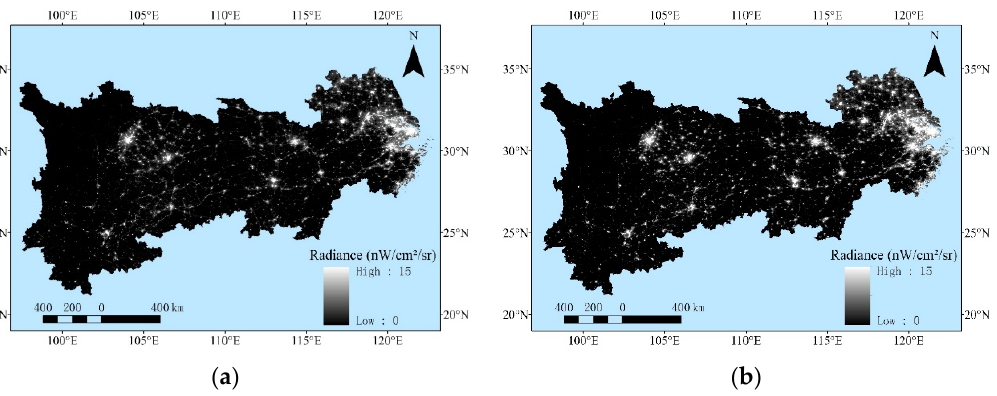
Figure 2. The night-time light images for YREB: ( a ) 2012; ( b ) 2019. Note: the radiance higher than 15 was set to 15 for demonstration.